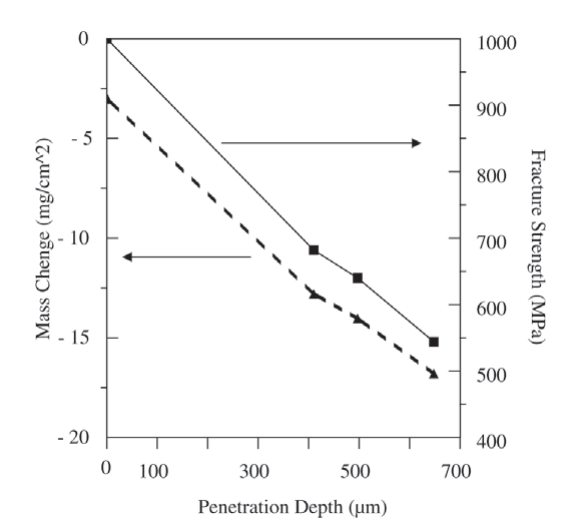
Figure 8. Correlation of mass change, penetration and fracture strength for the Si